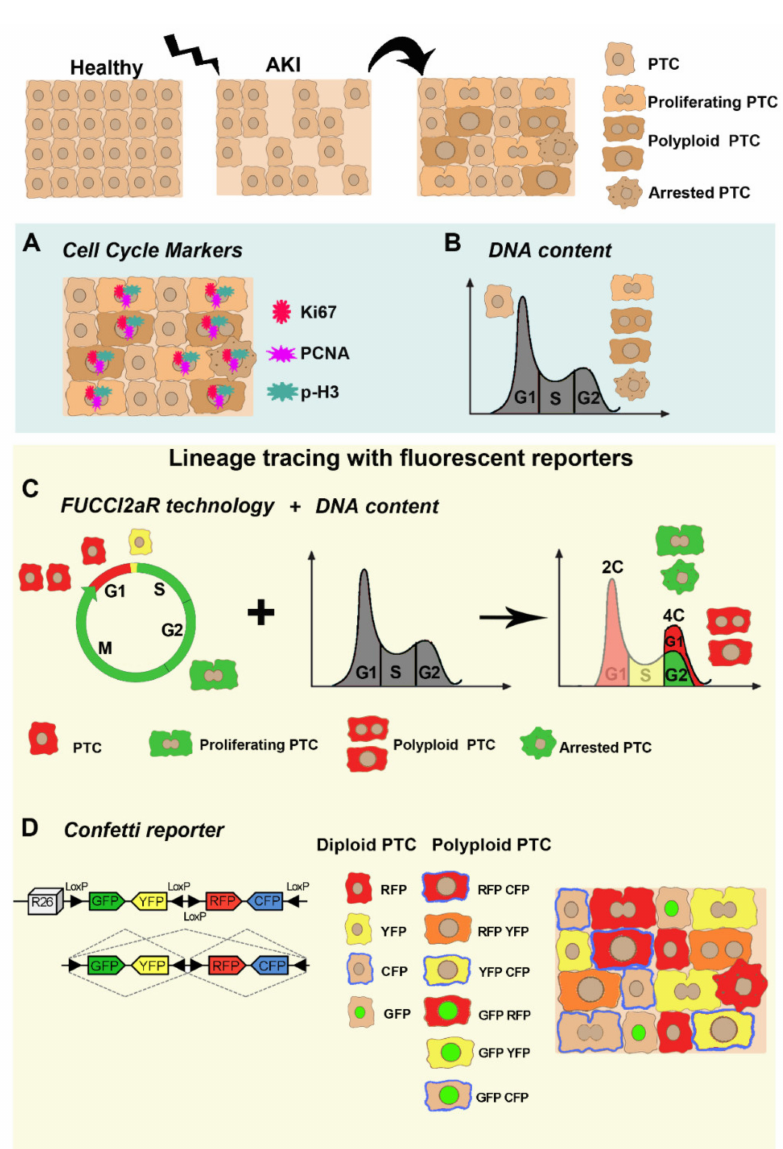
Figure 2. Old and new strategies employed to study cell cycle behavior of PTC after acute injury. PTC respond to acute injury by triggering different strategies: mitotic cell cycle, cell cycle arrest and alternative cell cycle. Use of cell cycle markers ( A ) and DNA content analysis ( B ) (light blue box; old strategies) cannot distinguish among the proliferating PTC (generated by “traditional” mitotic cell cycle) and the arrested PTC or the polyploid PTC (generated by alternative cell cycle). Recently, sophisticated strategies (light yellow box, new strategies) are now being employed to detect proliferating PTC, completing a mitotic cell cycle versus polyploid PTC generated by endoreplication. ( C ) The FUCCI2aR technology coupled with the measurement of the DNA content, can discern between PTC (diploids in G2/M), which express the mVenus protein (green cells), from